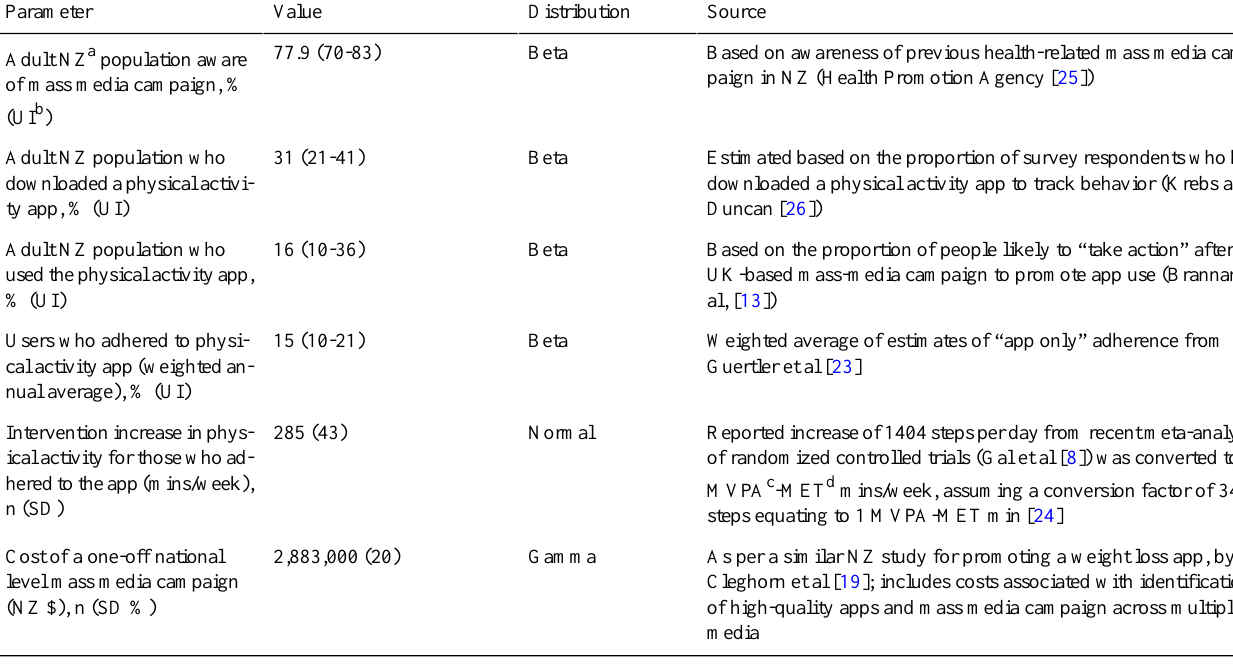
Table 1. Intervention parameters and uncertainty